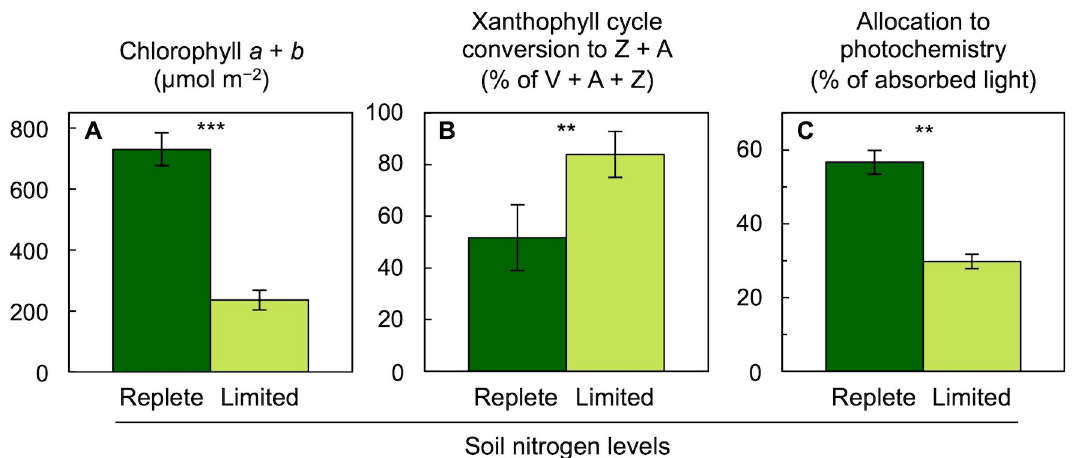
Figure 14. Impact of growth with replete (dark green columns) or limiting (light green columns) soil nitrogen levels on ( A ) chlorophyll content, ( B ) percent of the xanthophyll cycle converted to zeaxanthin + antheraxanthin (Z + A), and ( C ) percentage of absorbed photons allocated to photochemistry (quantified from chlorophyll fluorescence as photosystem II efficiency) in leaves of spinach grown in a naturally lit greenhouse. V = violaxanthin. Means ± standard deviations. Asterisks denote statistically significant differences between soil nitrogen levels (Student’s t -test; ** = p < 0.01, *** = p < 0.001). Data are from Logan et al. [74].